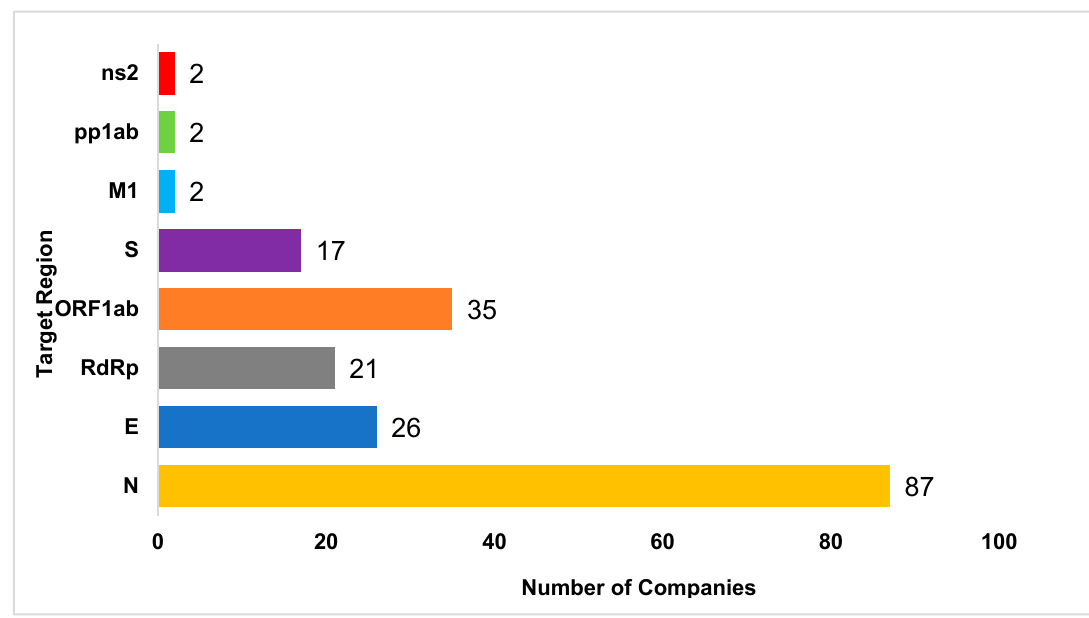
Figure 2. The number of commercial companies that use different target regions for designing the SARS-CoV-2 virus sequence in nucleic acid testing. The most common genes are the nucleocapsid gene, envelope gene, spike gene, ORF1ab gene, membrane gene, replicase polyprotein 1ab gene, and non-structural protein 2 gene. Among these, the most prevalent targeted gene is the nucleocapsid gene (73 / 163 companies). The scientific data was collected from the FDA website on 30 September